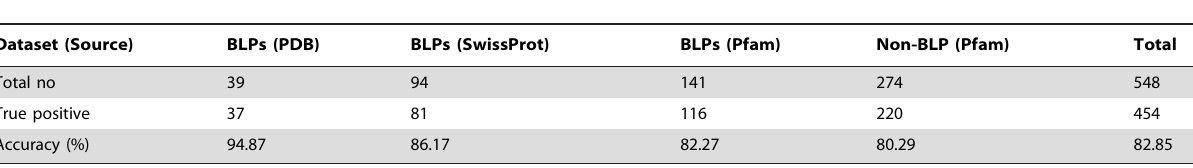
Table 3. The test performance (%) of SCMBLP on various data sets.